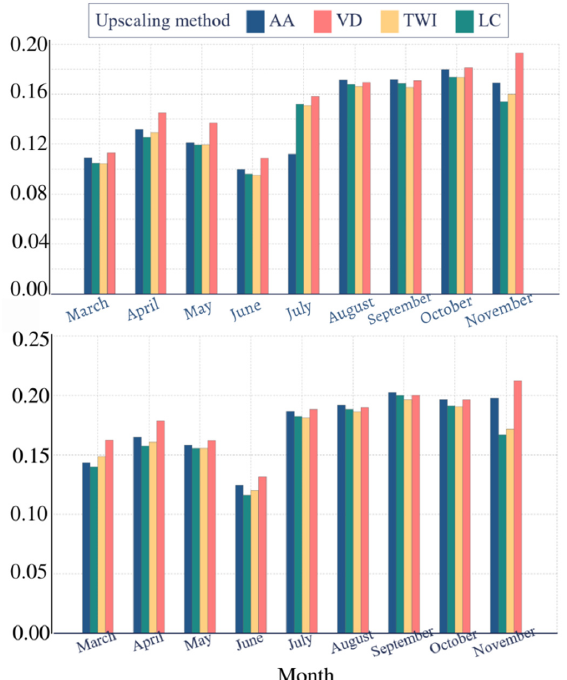
Figure 9. Temporal variation of monthly RMSD values (in m 3 .m − 3 ) for SMAP L2SMP_E AM overpass ( top ) and PM overpass ( bottom ) observations and in situ measurements derived from the upscaling techniques based on the Arithmetic Average (AA), Voronoi Diagram (VD), Topographic Wetness Index (T), and Land Cover (LC).